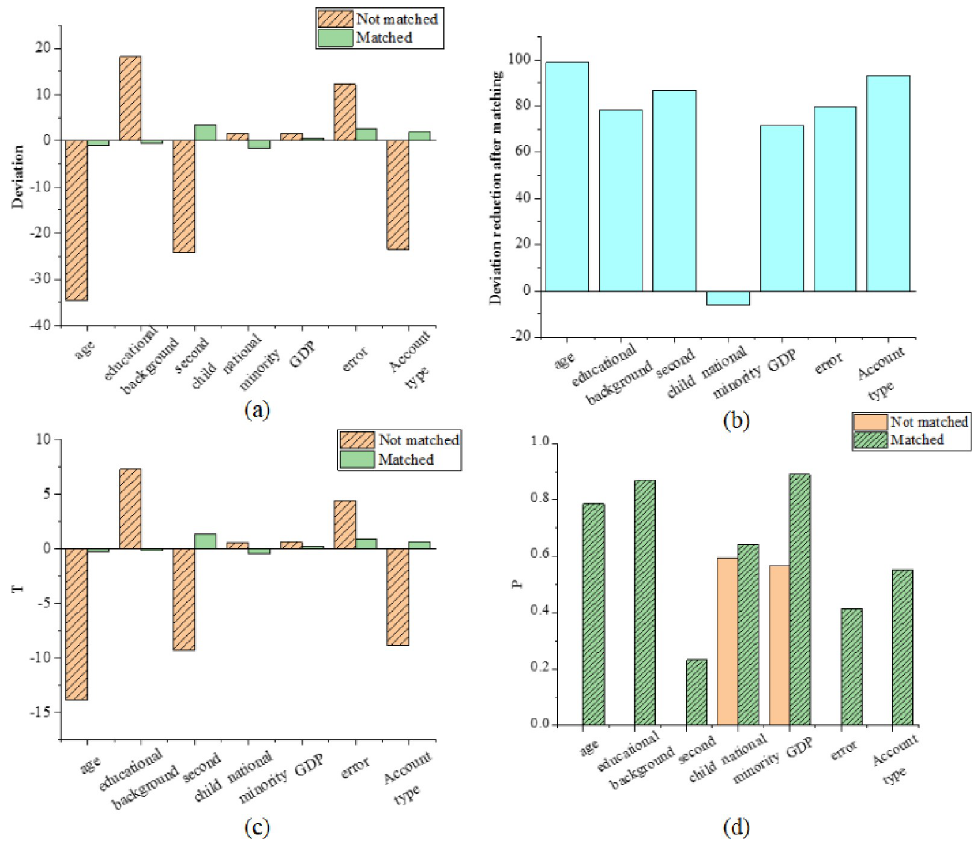
Fig 6. Results of a statistical test of propensity score matching quality (a) mean (b) regression coefficient (c) error (d) P.